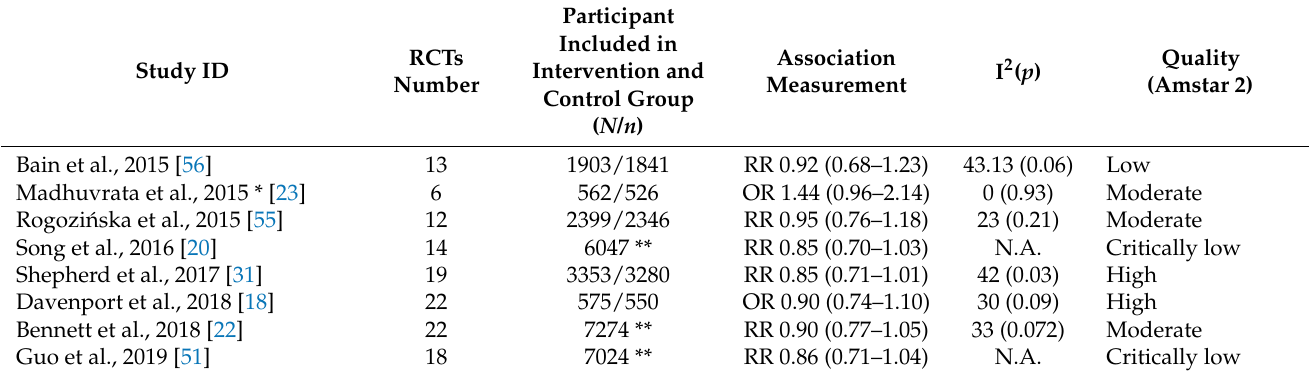
Table 4. Systematic reviews finding including mixed intervention in reducing